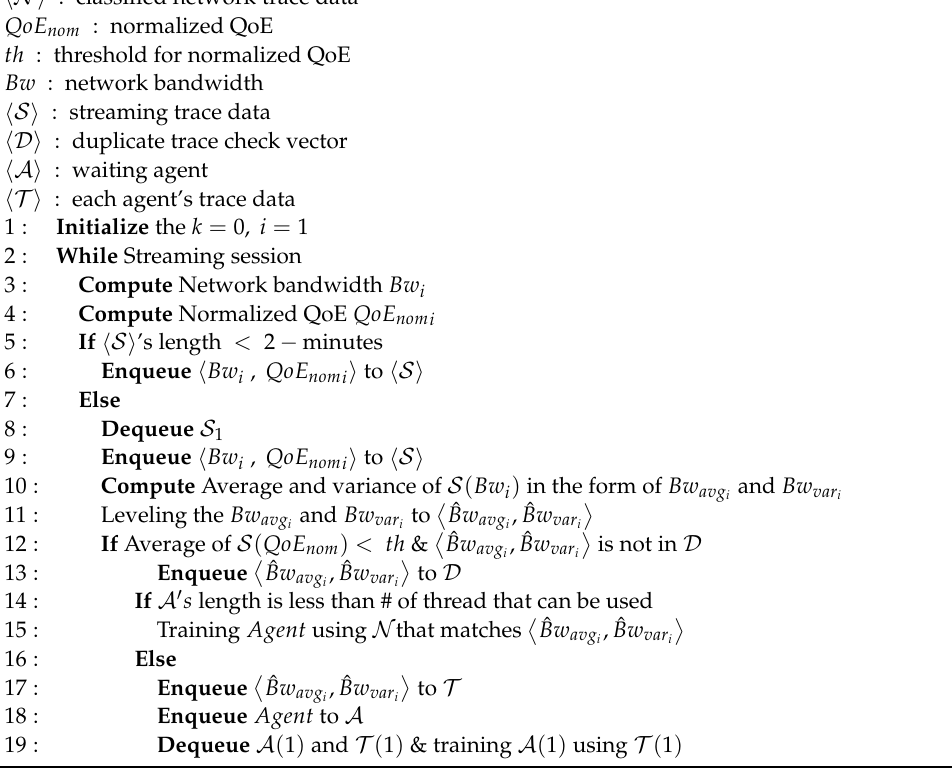
Algorithm 1 HTTP Adaptive Streaming with Online Reinforcement